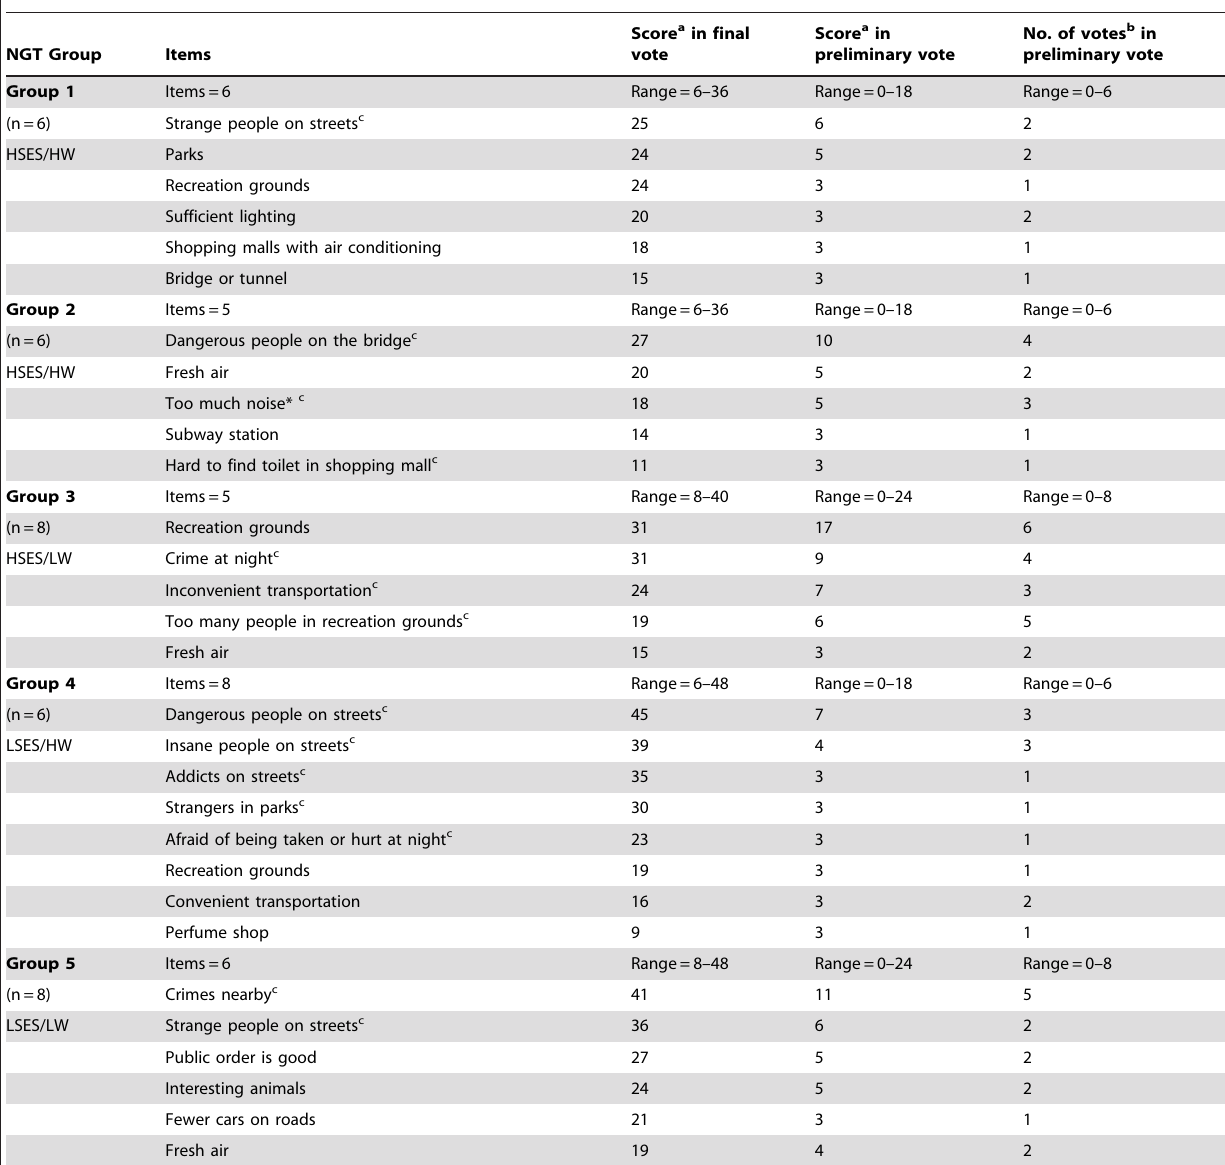
Table 2. Reserved Items Generated from Each NGT